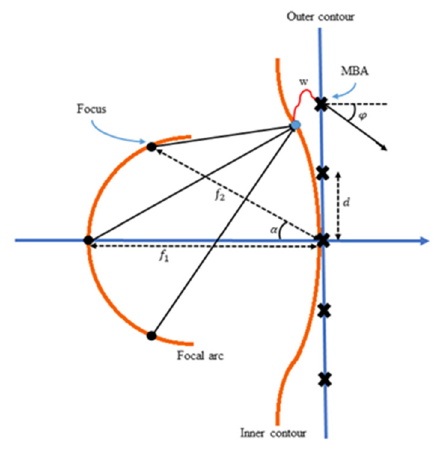
Figure 4. The geometry of a Rotman lens.